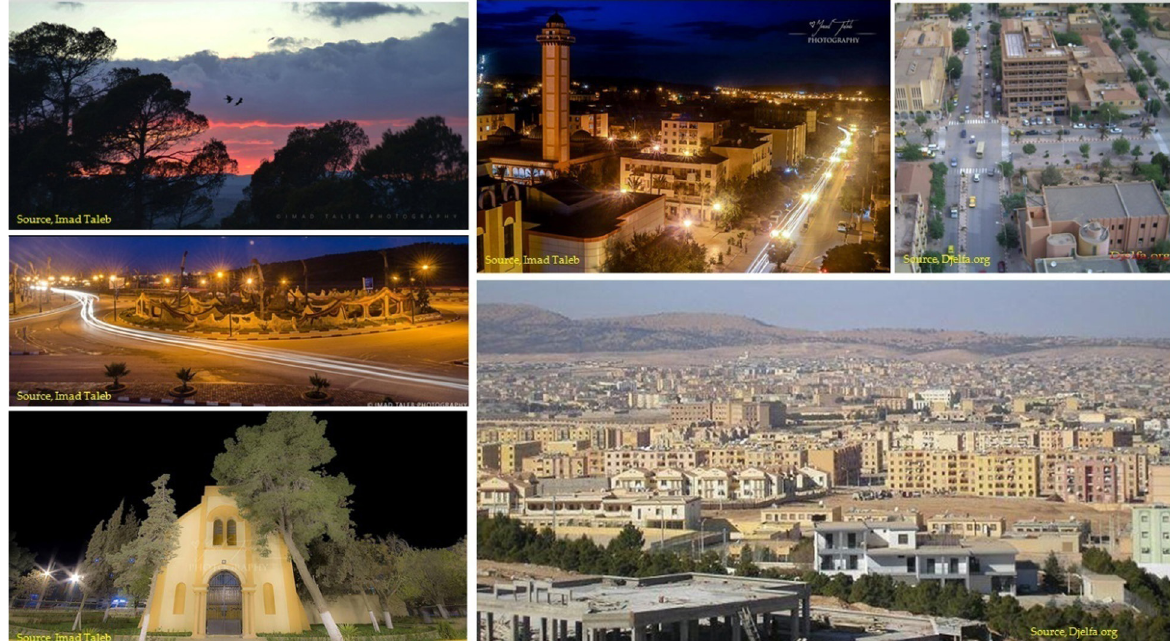
fig. 2. Djelfa in images, composed by